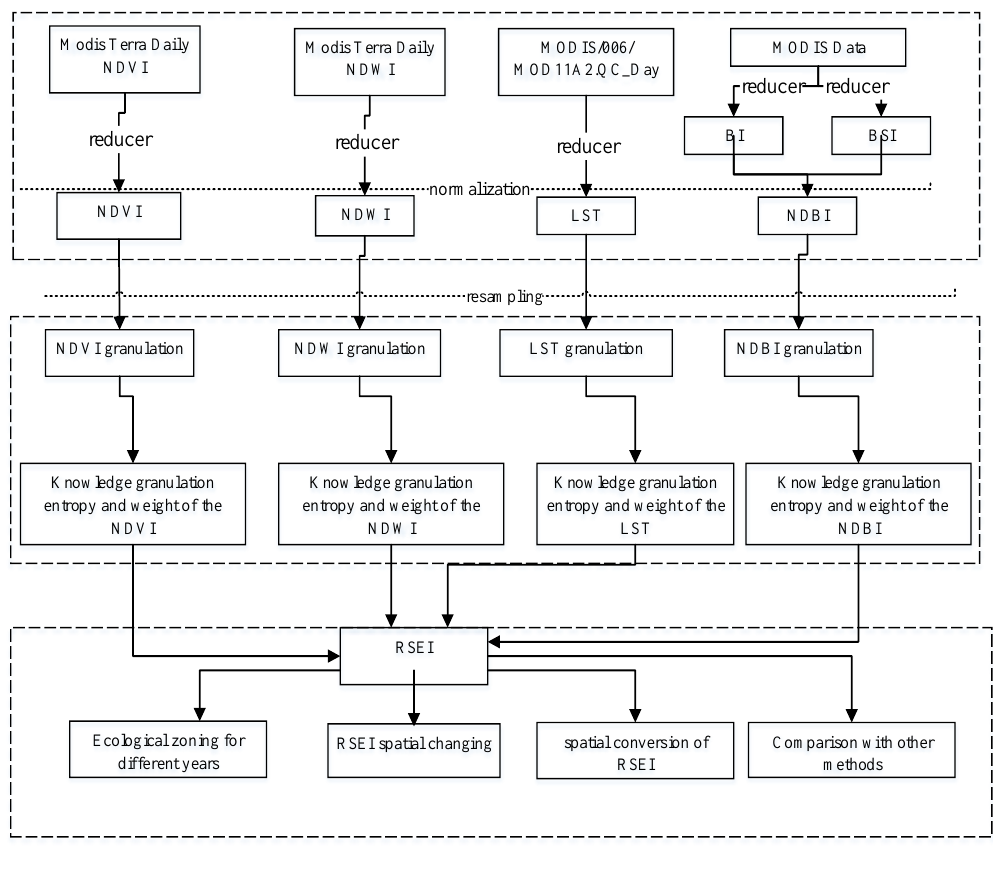
Figure 2. RSEI analysis framework of China.